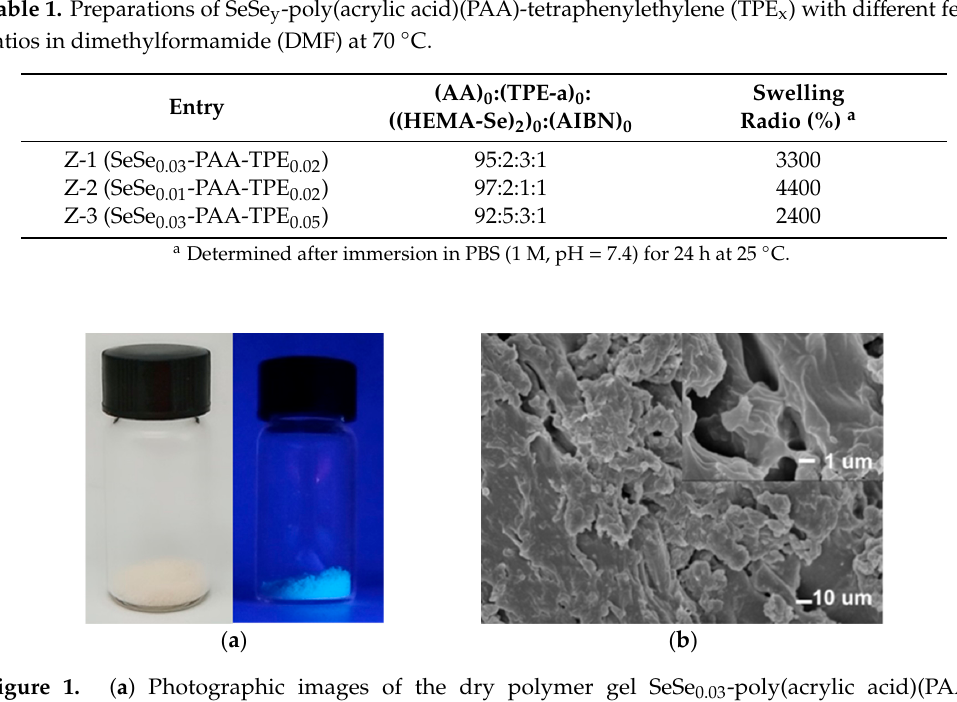
Figure 1. ( a ) Photographic images of the dry polymer gel SeSe 0.03 -poly(acrylic